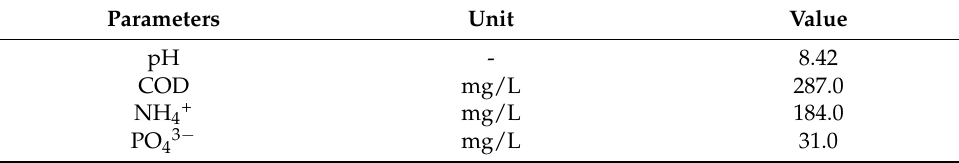
Table 3. Pollutants characteristics of the 2-fold diluted piggery